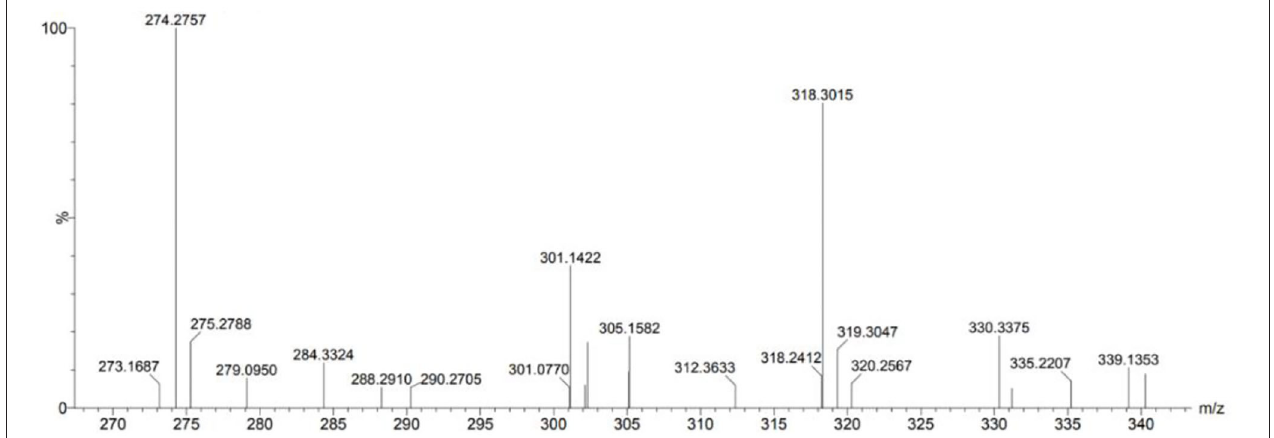
FIGURE 6 | Chromatogram from steam-exploded Eucommia ulmoides Oliver bark extracting